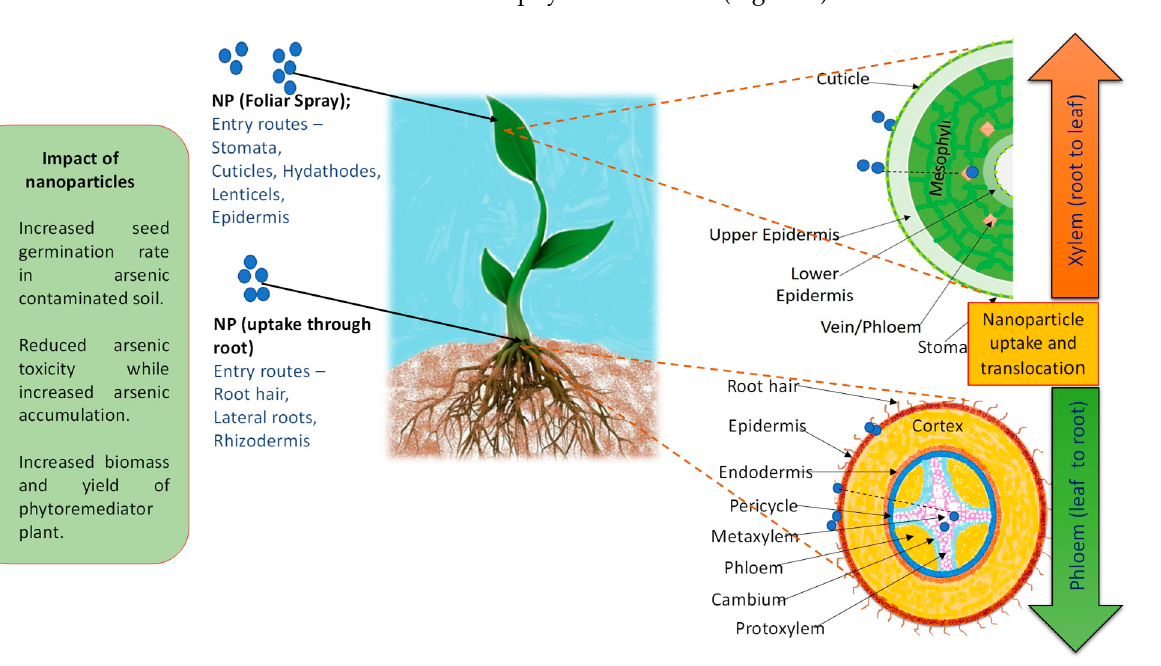
Figure 2. The use of nanoparticles through foliar spray and via roots can effectively enhance tolerance of plants to arsenic stress, improve their growth and biomass and also increase total arsenic accumulation.